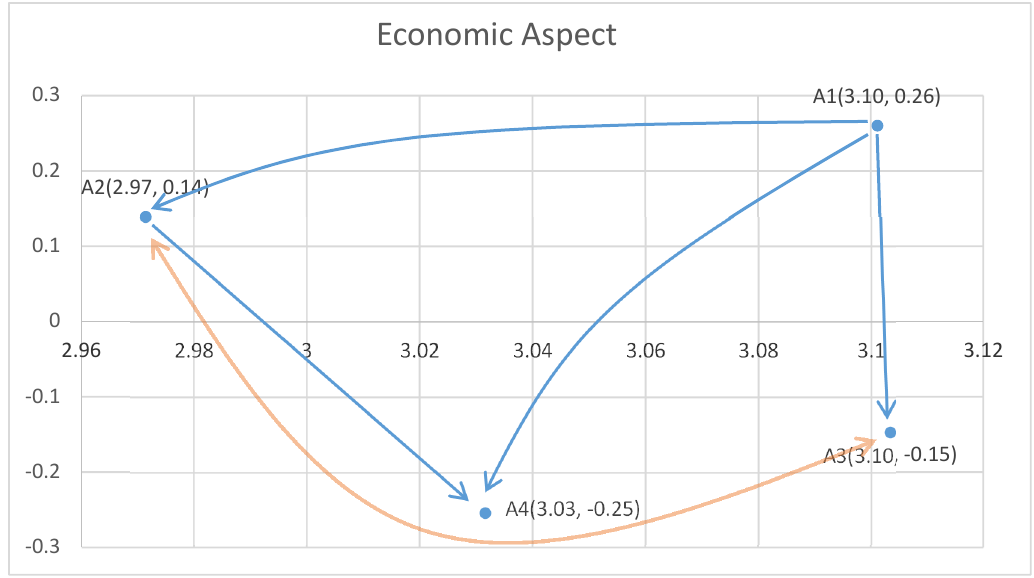
Figure 3. Scatter plot of correlation (D + R) and causality (D − R) for economic indicators.